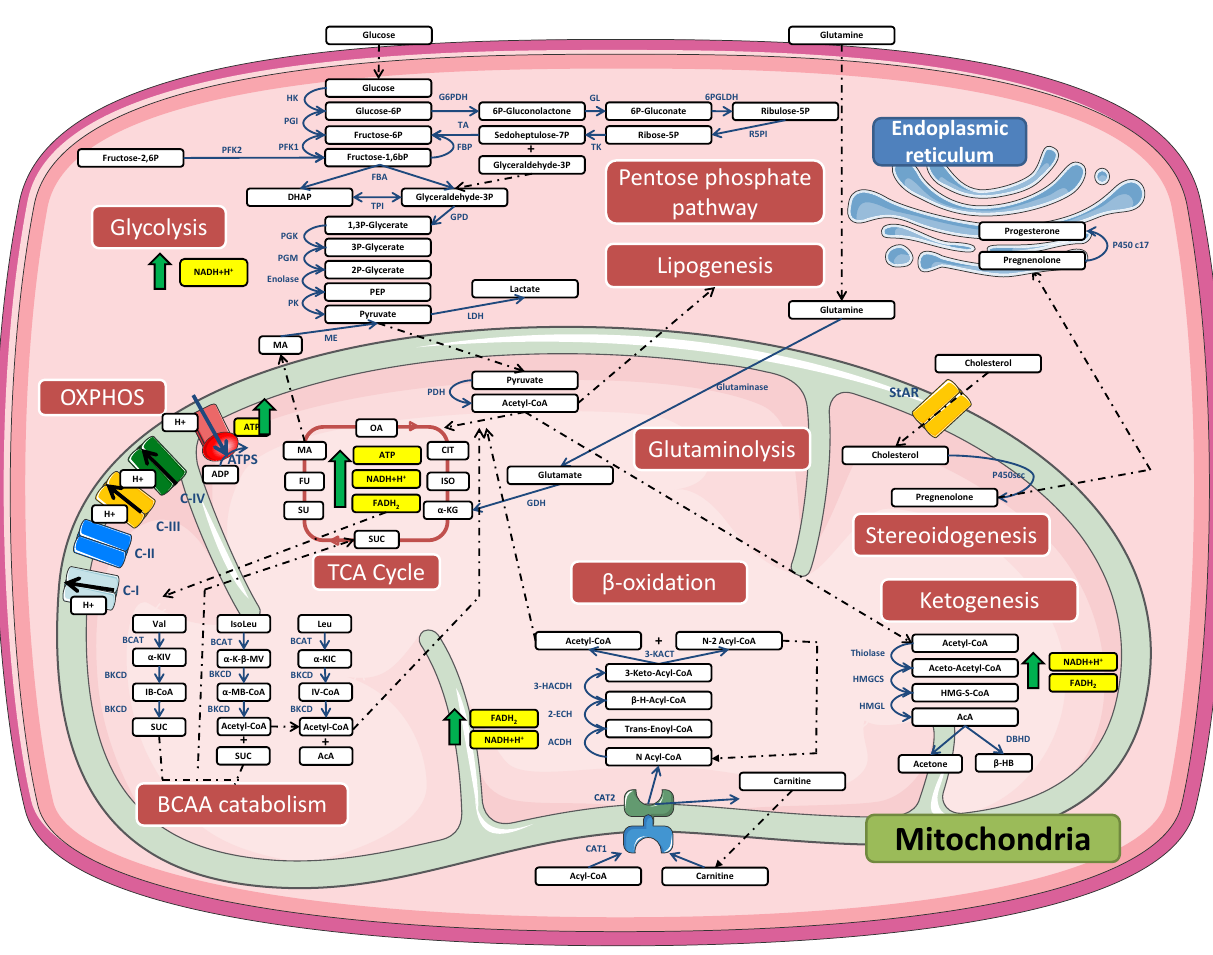
Figure 1 . Simplified representation of biochemical pathways related to